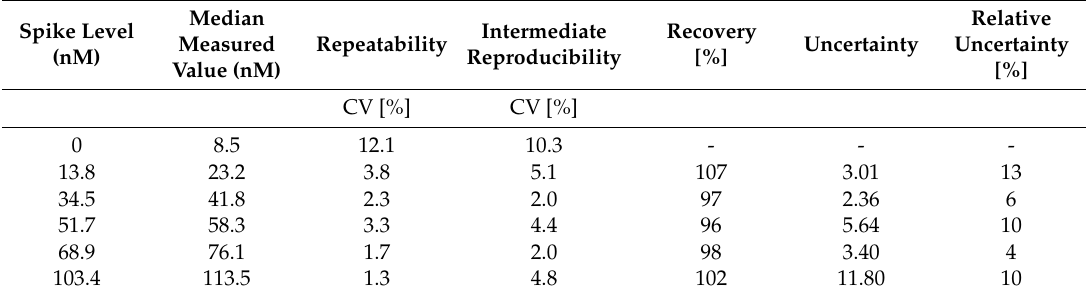
Table 1. Method performance characteristics at different spiking levels. CV, Coefficient of variation. Spike